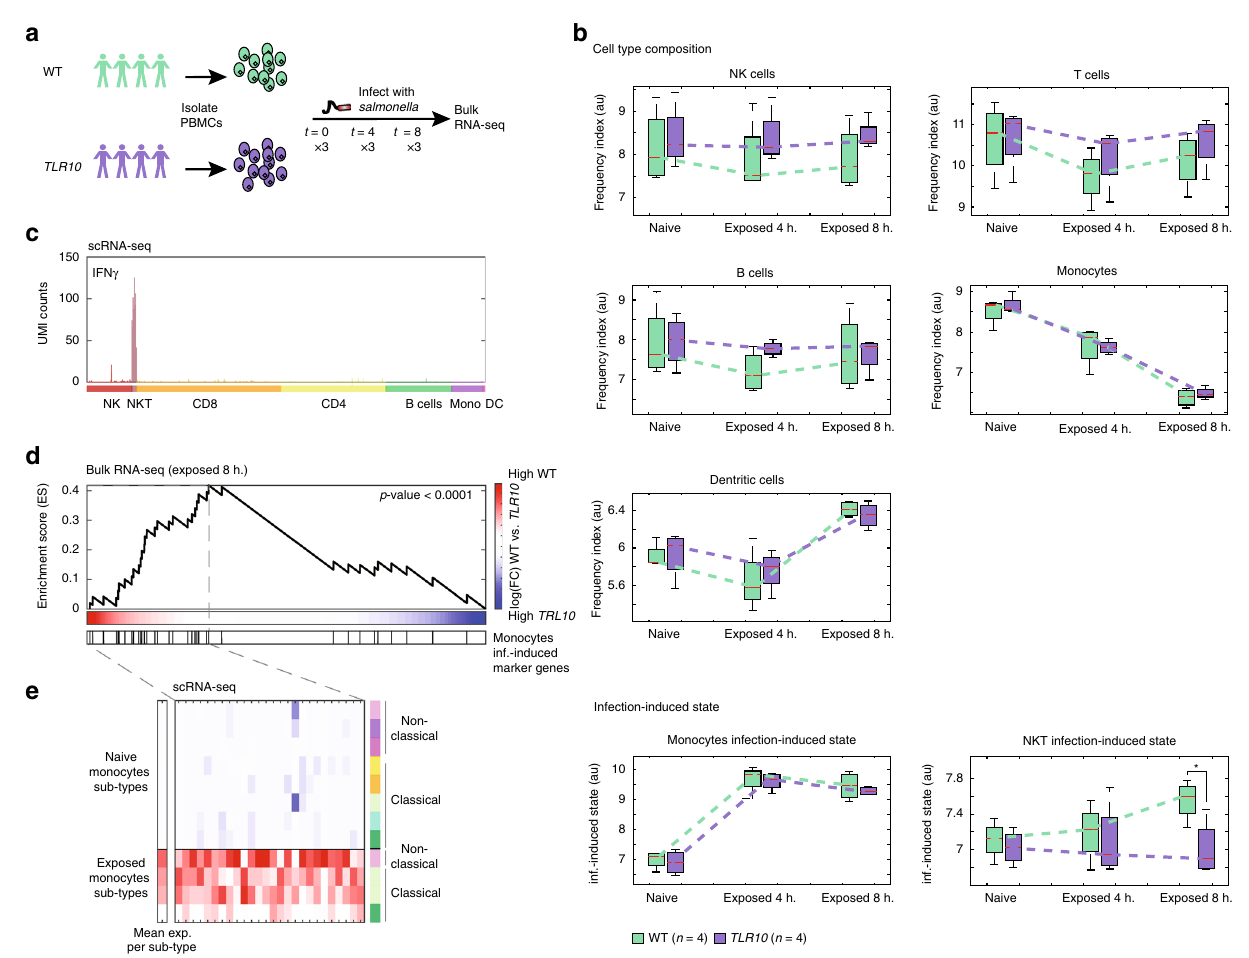
Fig. 4 Dynamic deconvolution of immune cell states reveals differences between WT and TLR10 individuals. a Overview of the bulk RNA-seq experiment: isolated PBMCs from blood of eight healthy individuals: WT (green) and TLR10 (purple), were infected ex vivo with Salmonella and bulk RNA-seq was measured before infection ( t = 0), 4 ( t = 4), and 8 ( t = 8) hours post-infection in triplicates. b Box-plots of the relative abundance or infection-induced state of each cell type before and 4 or 8 h post-infection in WT vs. TLR10 uncover signi fi cant difference in NKT infection-induced states following infection. The box represents the median and 25 – 75th percentile, whiskers encompass all data points. * p -value < 0.05, two sample t -test. Values are inferred from bulk measurements using our deconvolution algorithm; estimators of cell-type index are in arbitrary units (au). c Unique molecular identi fi er (UMI) counts of IFN γ from each cell by scRNA-seq data revealed production of IFN γ exclusively from NKT cells 4 h post-infection; color-coded cell types are indicated at the bottom. d Gene Set Enrichment Analysis (GSEA) of the ‘ monocytes infection-induced genes ’ in the genes that are higher in WT relative to TLR10 individuals 8 h post-infection (see methods) reveals partition of the gene signature into two sets which imply differences in sub-types activation following infection. Red to blue bar at the bottom represents the gene expression fold change between WT and TLR10 individuals (see also colorbar to the right); the black bars below indicate positions of the ‘ monocytes infection-induced genes ’ in the ordered list of genes. p -value is calculated by the maximal Enrichment Score (ES), which also de fi nes the group of enriched genes (all genes to the left of the maximal ES position, i.e. the dashed line). e Expression matrix (scRNA-seq data) of the set of ‘ monocytes infection-induced genes ’ that were enriched in the genes that are higher in WT relative to TLR10 (genes to the left of the dashed line in d ). Presented is the mean expression of these genes from each cell sub-type of the naive and exposed monocytes. The left bar represents the mean expression of these genes in each sub-types; monocytes sub-types color-coded as in Fig.